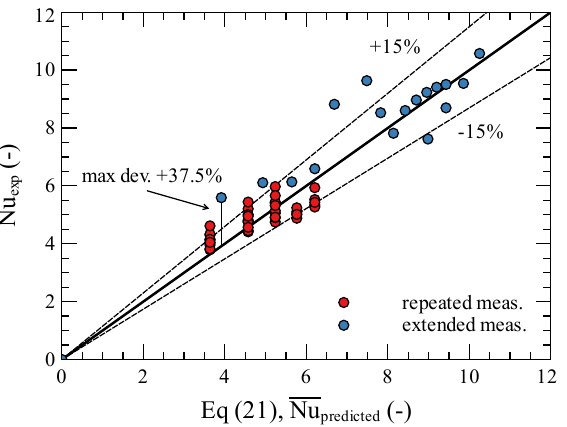
Figure 13. Comparison of experimental values and established correlations. The maximum deviation of the data is 37.5%; the average deviation is less than 15%.